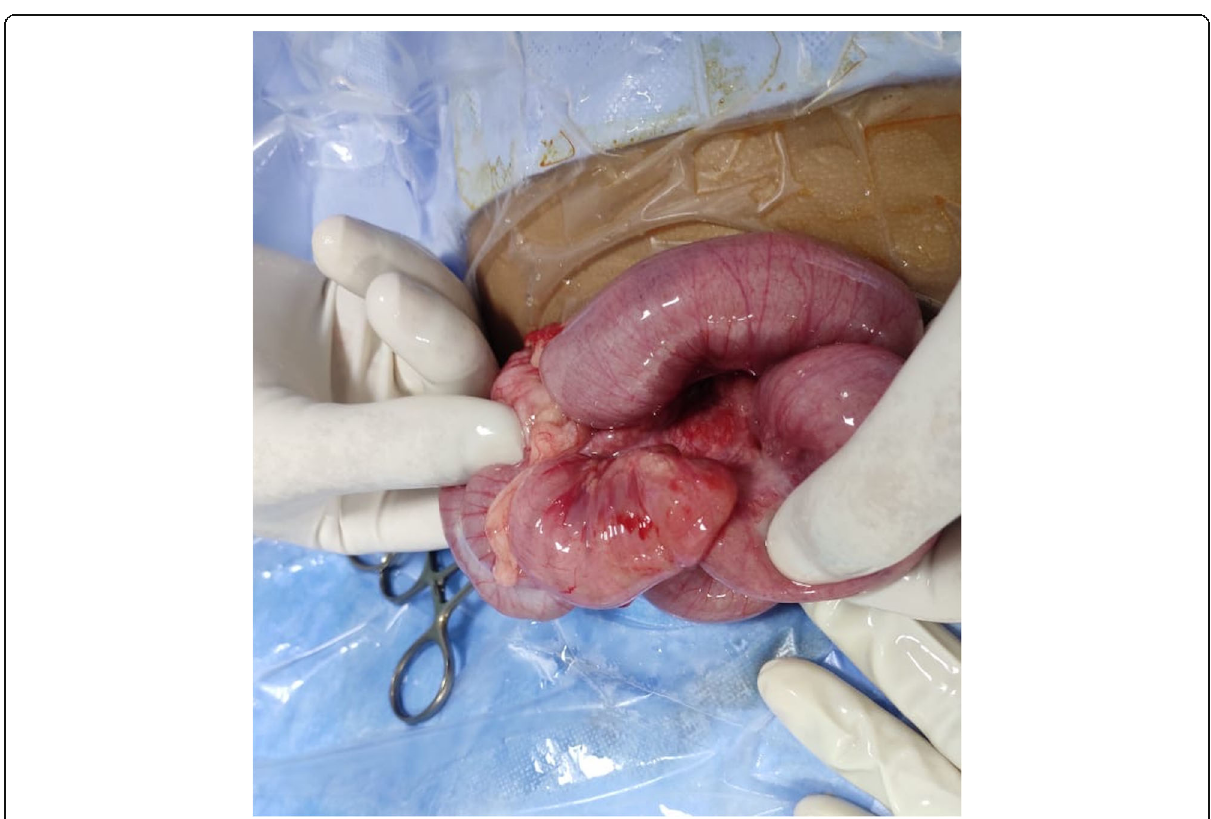
Fig. 2 Patient D with failed non-operative